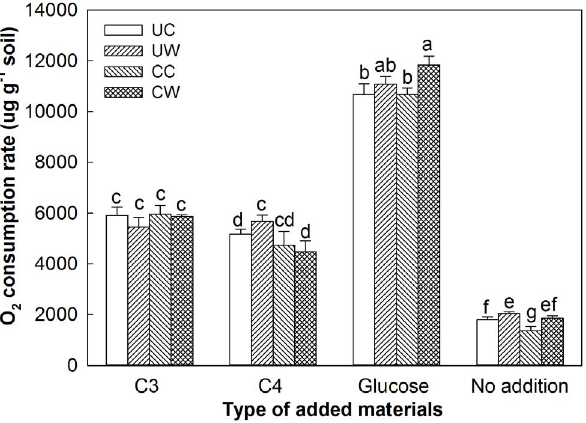
Figure 2. Total soil respiratory C release (i.e., O 2 consumption rate) with the addition of C 3 plant material, C 4 plant material, or glucose or without additional substrate under four treatments during the incubation period. Vertical bars and their error bars represent means and standard errors ( n 5 4). UC: unclipped control; UW: unclipped and warmed; CC: clipped control; CW: clipped and warmed. The different letters indicate statistical significance.